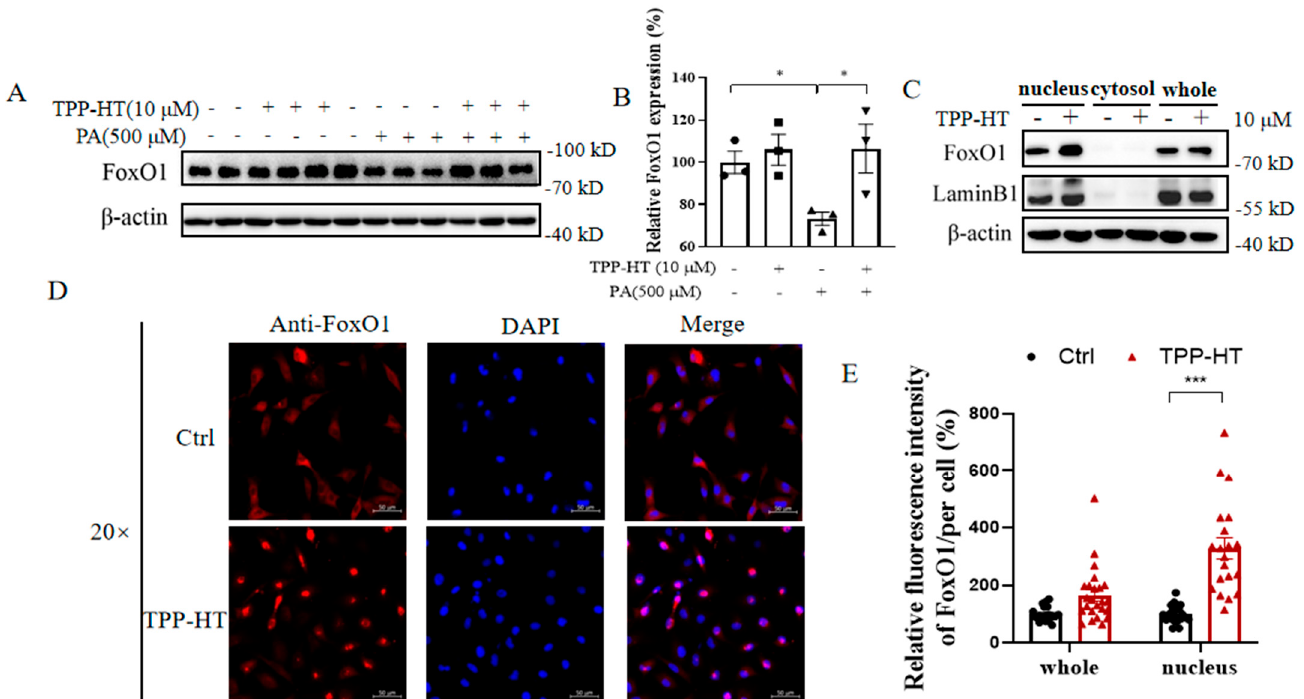
Figure 4. TPP-HT prevents PA-induced downregulation of FoxO1 and augments FoxO1 nuclear localization in HAECs. HAECs were treated with TPP-HT (10 μ M) for 24 h and then treated with or without PA (500 μ M) for another 24 h. ( A ) Protein level of FoxO1. ( B ) Arbitrary unit for the protein level of FoxO1. ( C ) Protein levels of nuclear, cytosolic and whole levels of FoxO1, LaminB1 as nuclear loading controls. ( D ) Fluorescence intensity of FoxO1, scale bar = 50 μ m. ( E ) Arbitrary unit for the fluorescence intensity of FoxO1 (statistical cell number for control is 22, for TPP-HT is 25). Values are the mean ± SEM from at least three independent experiments. * p < 0.05, *** p < 0.001.